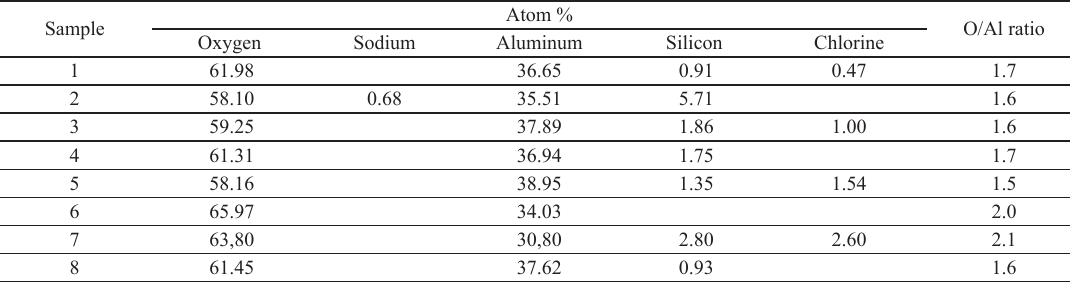
Table 7. Full factorial experimental design results for EDS analysis.